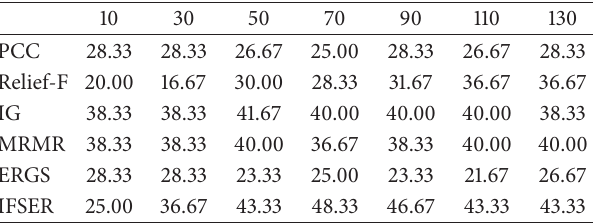
Table 4: Classification accuracies (%) of different feature selection methods with C4.5 on 9 Tumors database.